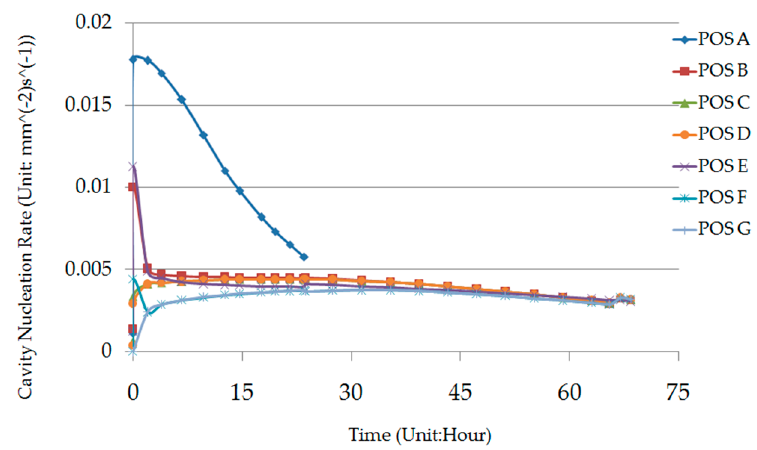
Figure 12. Evolution of the cavity nucleation ratio.